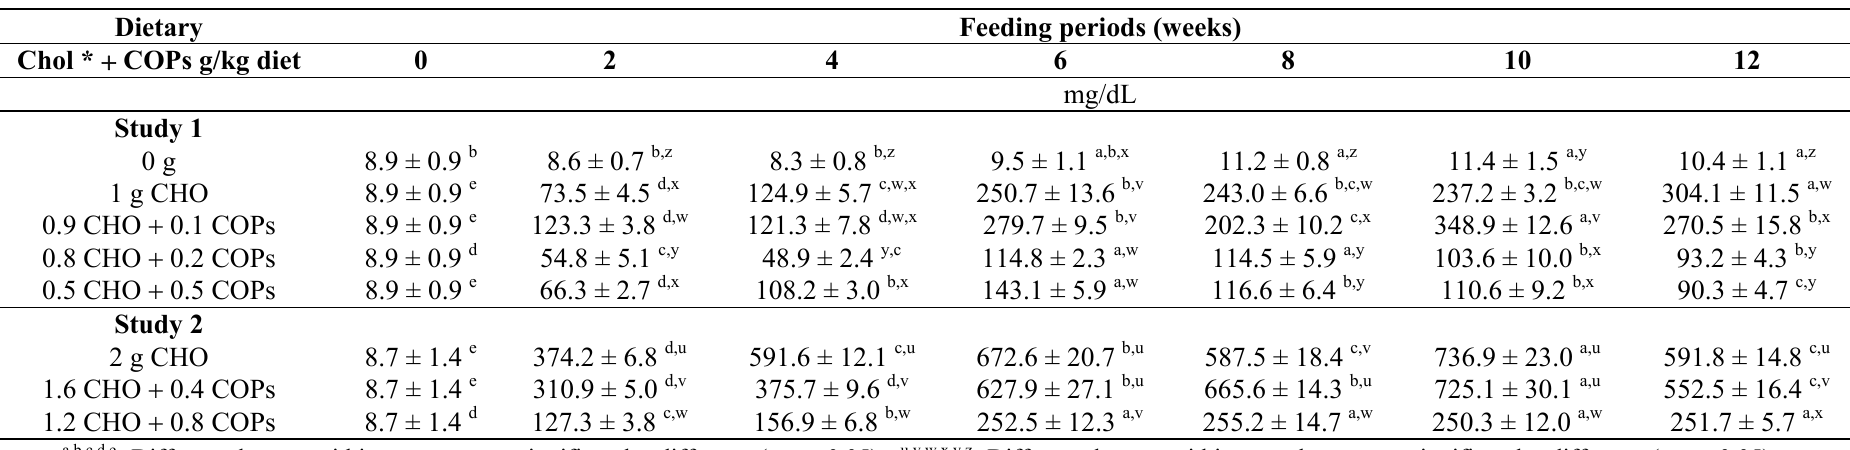
Table 4. Effect of dietary cholesterol and cholesterol oxides on LDL-cholesterol content in serum. Dietary Feeding periods (weeks)